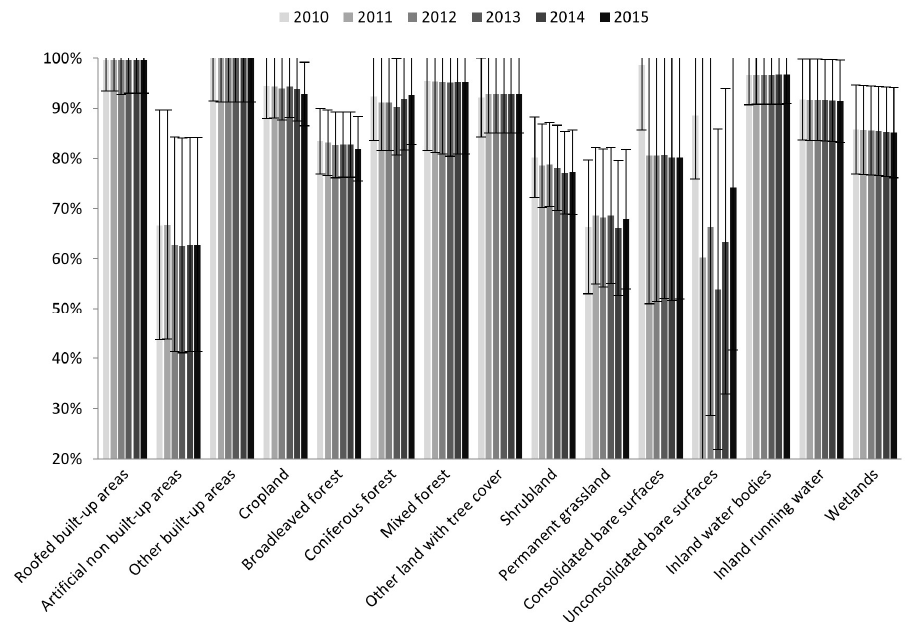
Figure 6. Estimated producer’s accuracy of the maps with a 95% confidence interval.